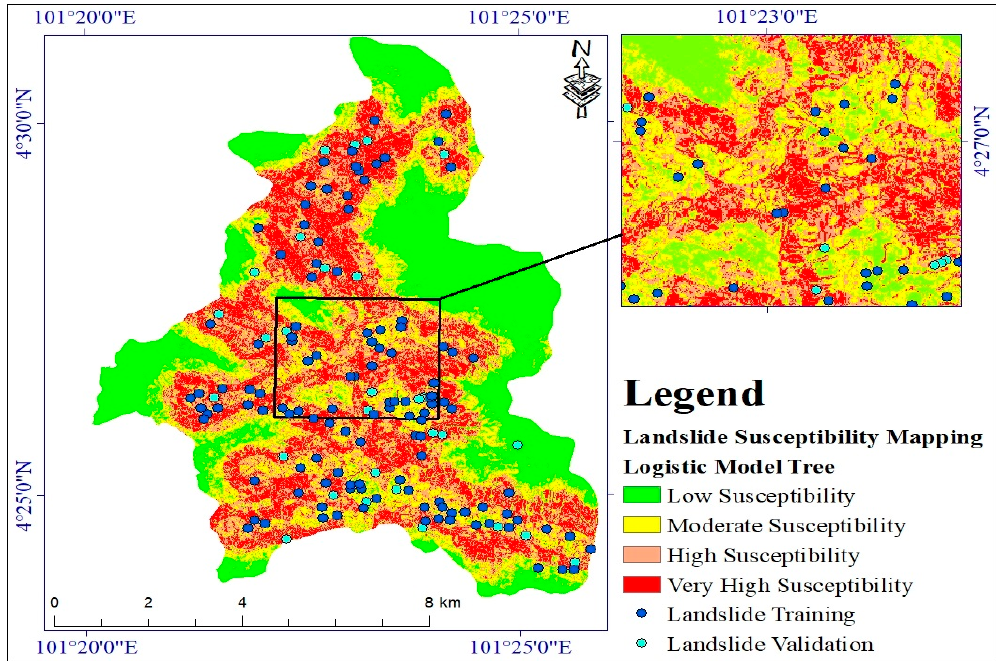
Figure 10. Landslide susceptibility map produced from the logistic model tree (LMT) model.